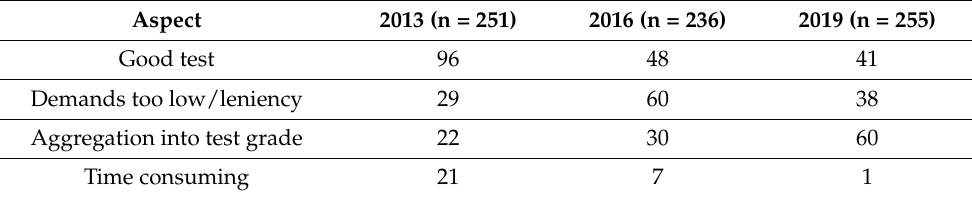
Table 6. Variation of aspects emphasized in teachers’ open comments on the whole test and Part C in the 2013, 2016 and 2019 questionnaires (number of comments/raw